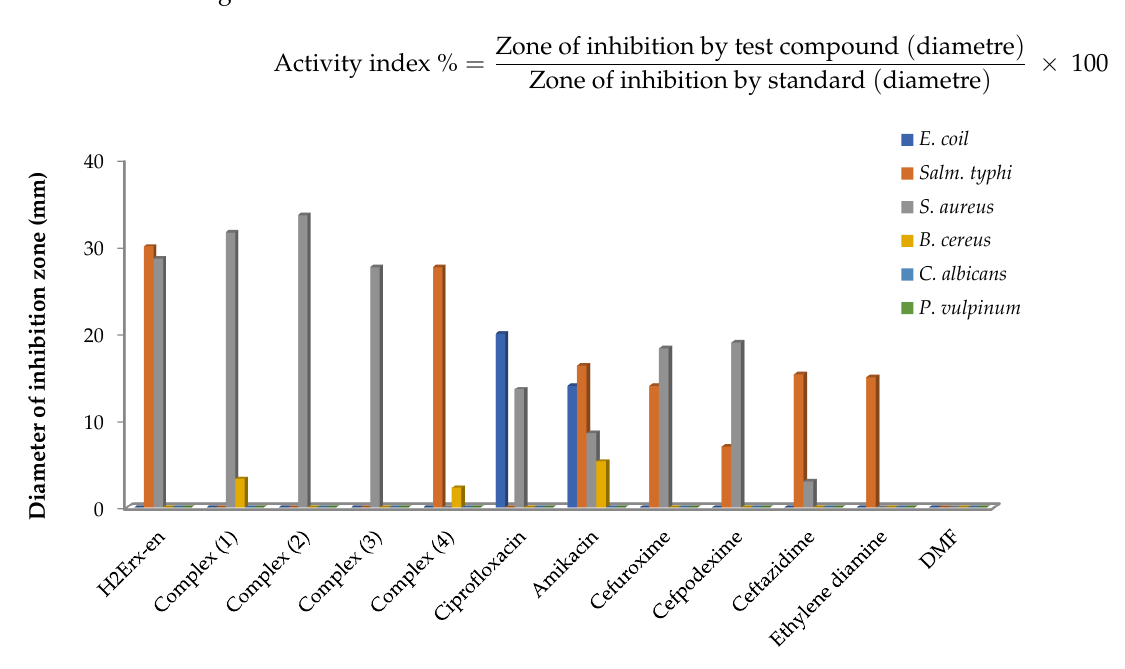
Figure 1. Antimicrobial activity of H 2 Erx-en and its metal complexes.